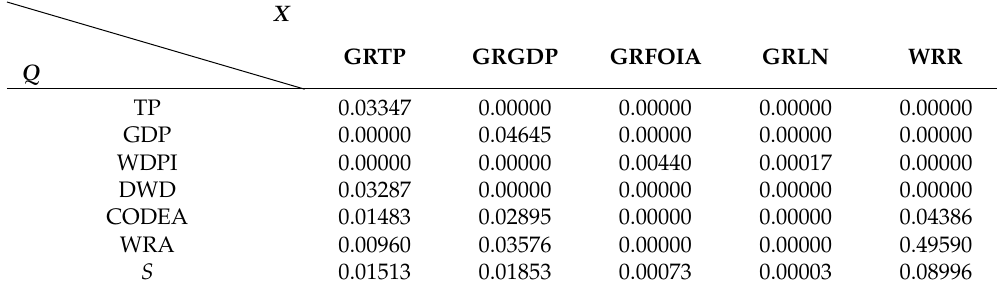
Table 3. Results of sensitivity